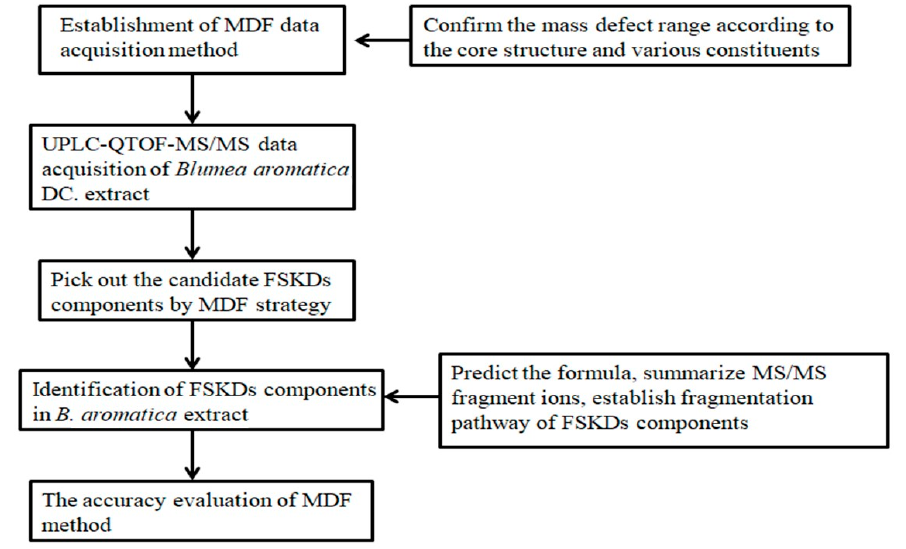
Figure 1. Flow diagram illustrating the approach used to screen forskolin-type diterpenoids from B. aromatica .